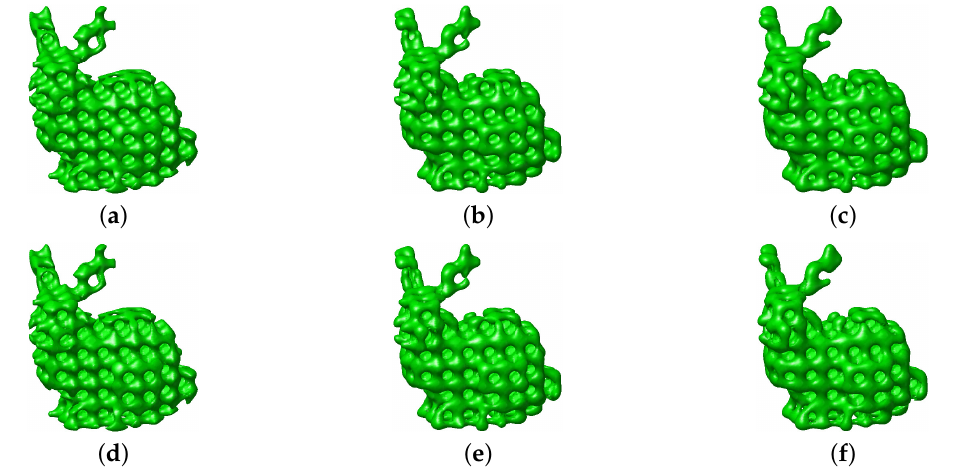
Figure 20. ( a – c ) are snapshots of phase separation on the Stanford Bunny at t = 40 ∆ t , t = 120 ∆ t , and t = 160 ∆ t , respectively. ( d – f ) are snapshots of phase separation with replacing initial values inside the object at t = 40 ∆ t , t = 120 ∆ t , and t = 160 ∆ t , respectively. Here, the local average concentration function Equation (13) is